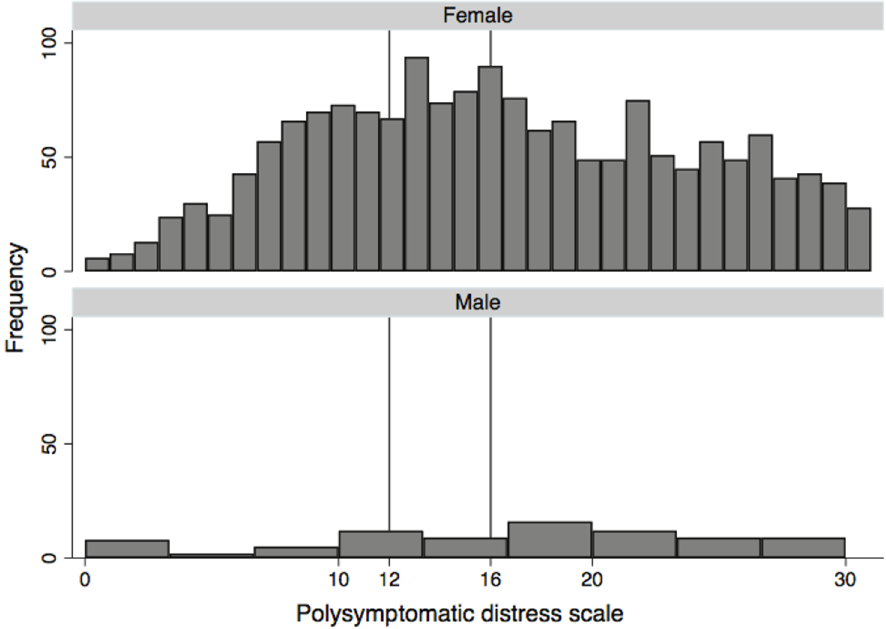
Fig 1. Histogram of PSD scores in patients referred to NDB with diagnosis of fibromyalgia (S1 File). A PSD (cid:21) 12 has a sensitivity of 100% for fibromyalgia diagnosis, but best cut point for correct classification is (cid:21) 16 (87.9%). Women represent 95.3% of subjects. Overall, 52.8% satisfy 2016 criteria (52.6% of women and 56.1% of